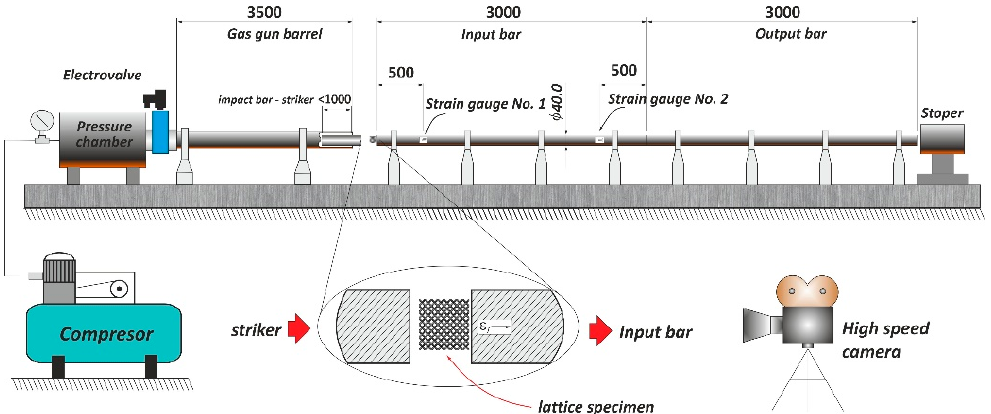
Figure 15. The general view of the split Hopkinson pressure bar laboratory set up used to carry out impact loading tests.